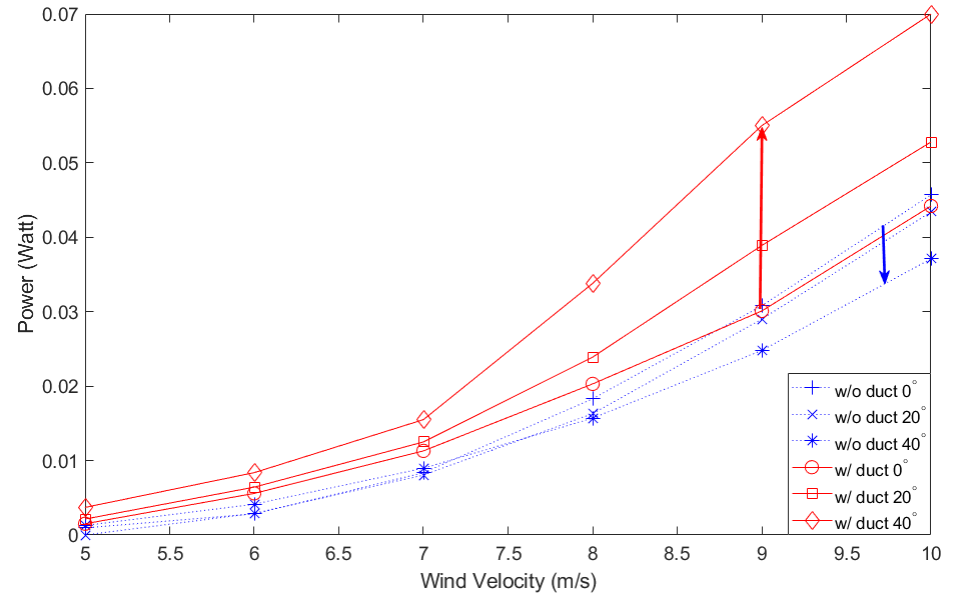
Figure 9. Power generation performance of a micro wind energy harvester with an angle corresponding to the wind direction.